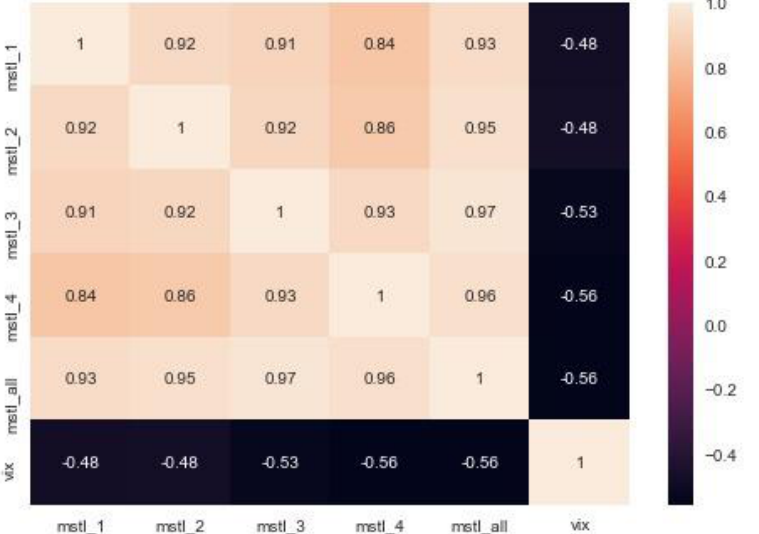
Figure 2. MSTLs and VIX correlation. This figure shows the resulting correlation among each MSTL quartile, the MSTL of all ETFs and the VIX. Source: authors ’ elaboration.